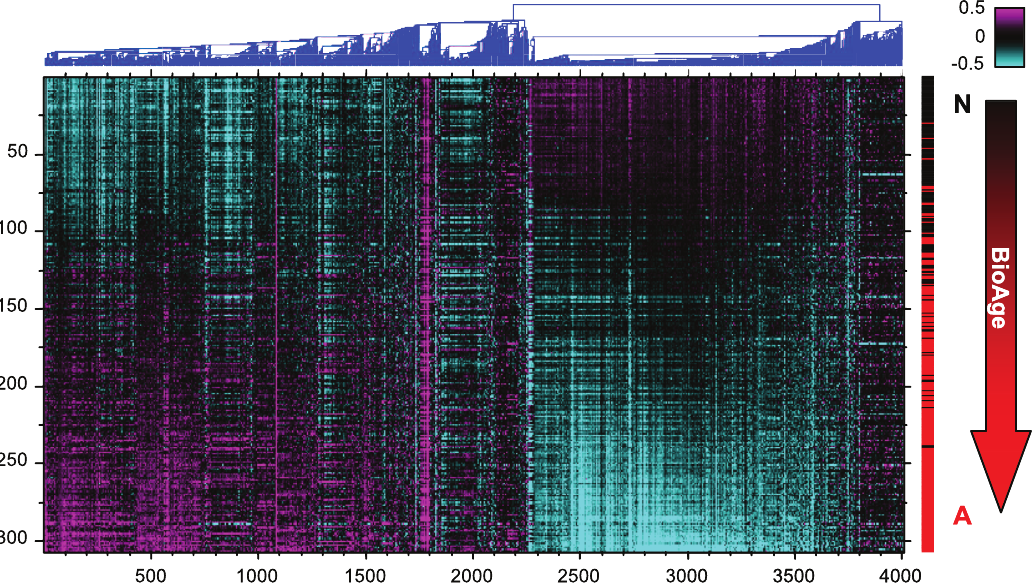
Figure 1. Gene expression in PFC1. The heat map shows hierarchical clustering of the 4000 most variable genes. The samples (rows) are sorted according to the values of the first principal component of the complete dataset and labeled according to diagnosis (normal samples in black, AD samples in red on the right).